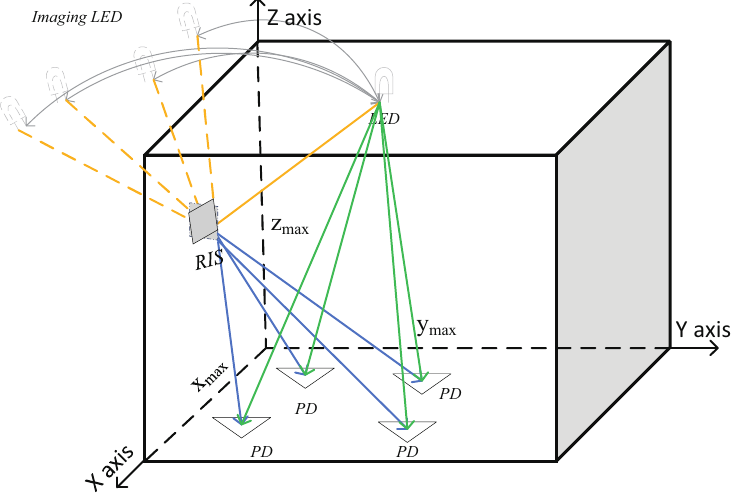
Figure 2. Scenario 2: An indoor VLC system contains an AP, a mobile user, and an RIS. The channel of VLC systems contains two parts: the line-of-sight (LoS) and